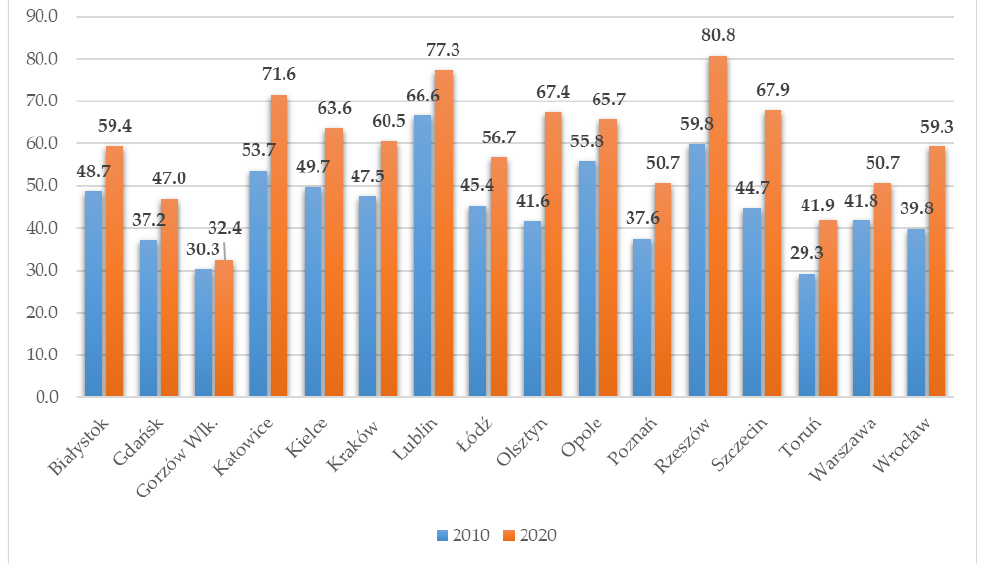
Figure 5. The number of physicians per 10,000 residents in the surveyed Polish cities in 2010 and 2020.